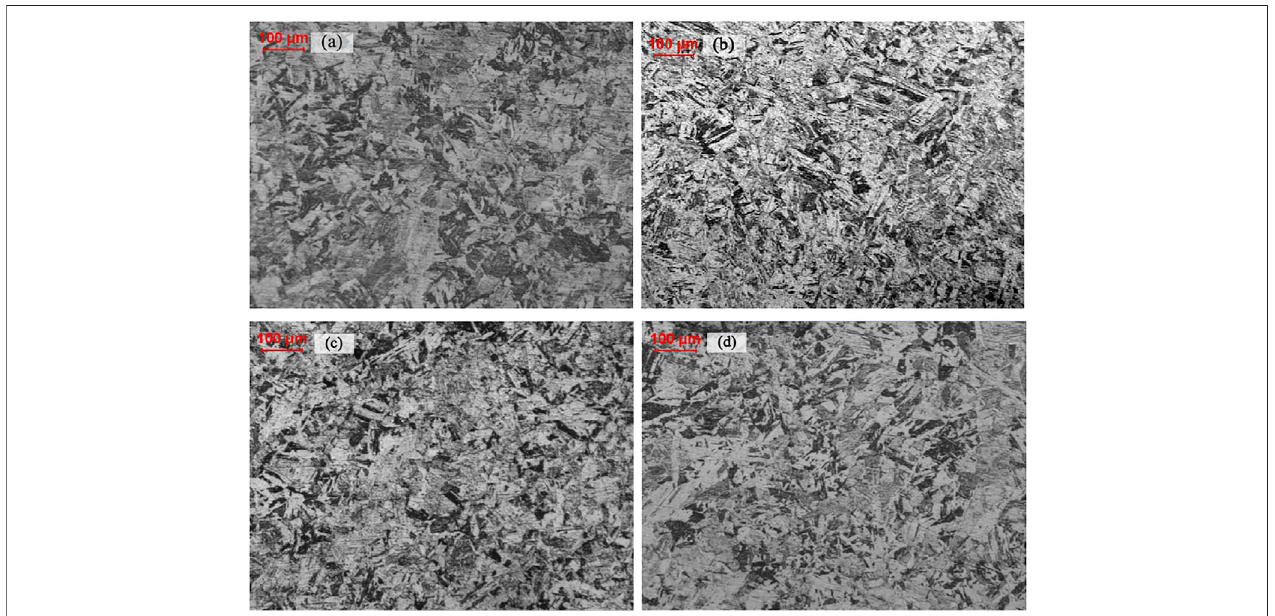
FIGURE 1 | Microstructure of Group A NSM steel specimens heated at different rates of (A) 0.1 ° C/s, (B) 1 ° C/s, (C) 2 ° C/s and (D) 5 ° C/s.